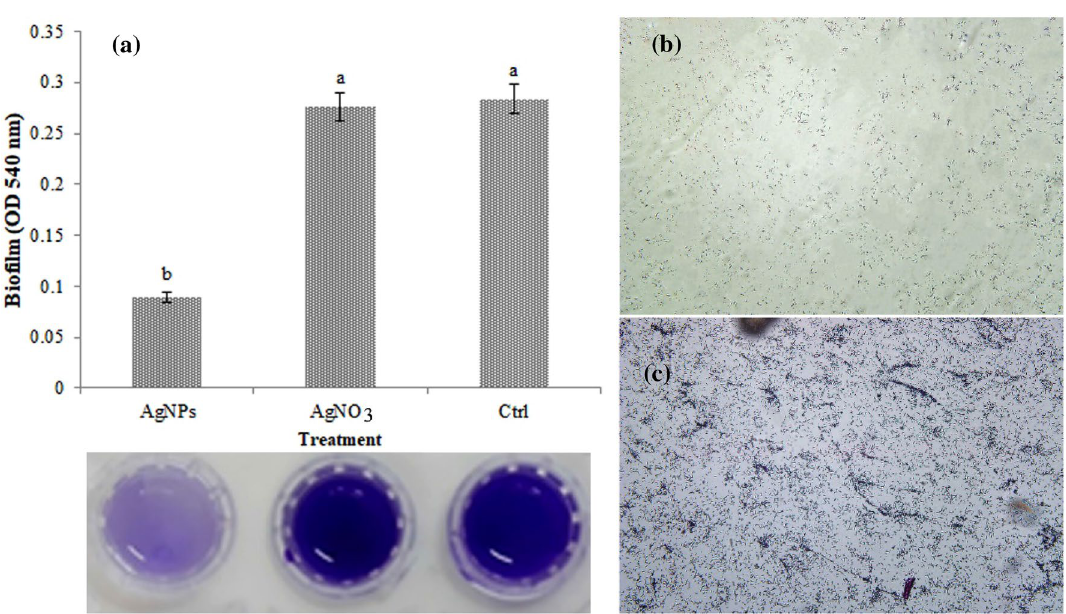
Figure 8. Effect of AgNPs biosynthesized by Pseudomonas canadensis Ma1 on ( a ) biofilm formation of Pseudomonas tolaasii Pt18, and representative bacterial cells staining ( b ) treated with AgNPs, and ( c ) untreated control. The graph represents the mean of three replicates. Error bars indicate the SE of the three replicates. Different letters indicate significant differences (p =